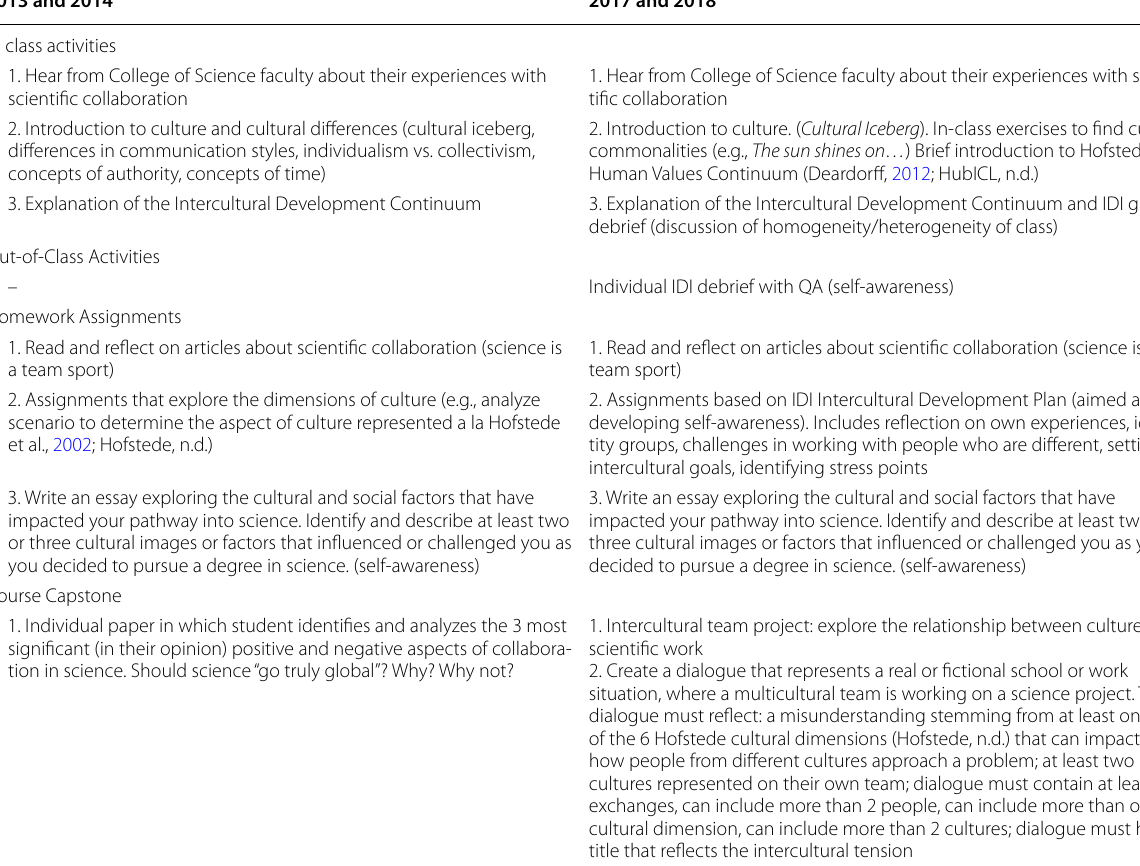
Table 6 Changes made in the leadership seminar from 2013 and 2014 to 2017 and